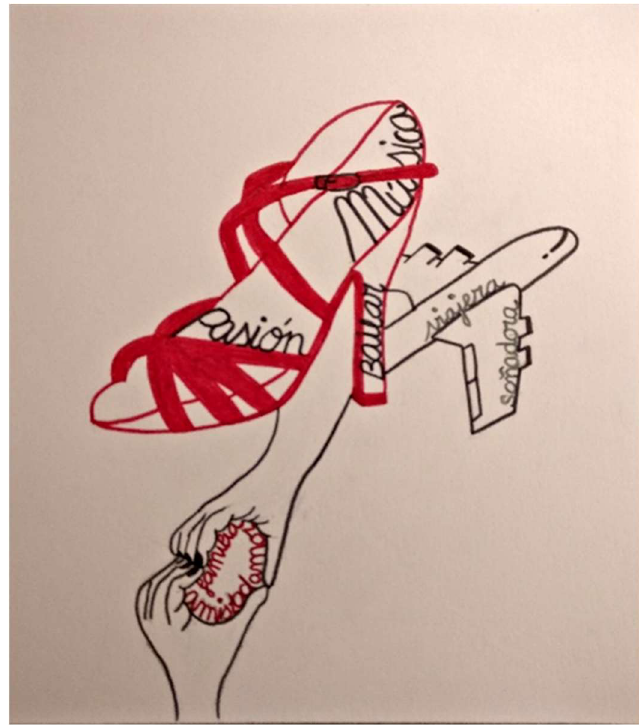
Figure 2. Dreaming. Drawing (CRIGO).